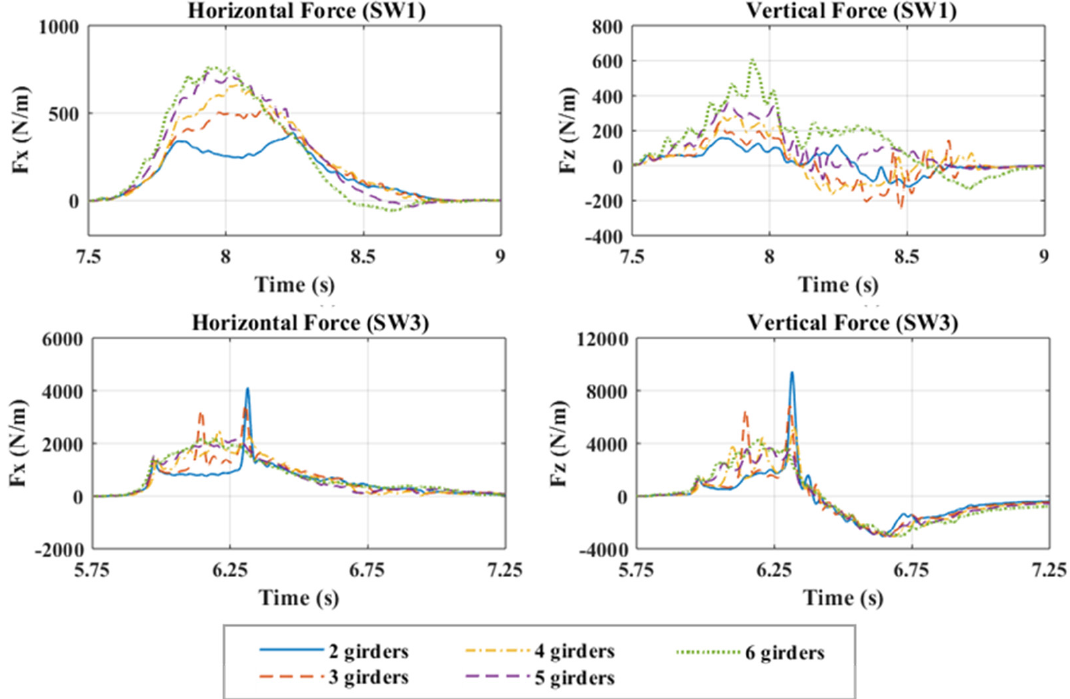
Figure 8. Time histories of wave forces on decks with a different number of girders.